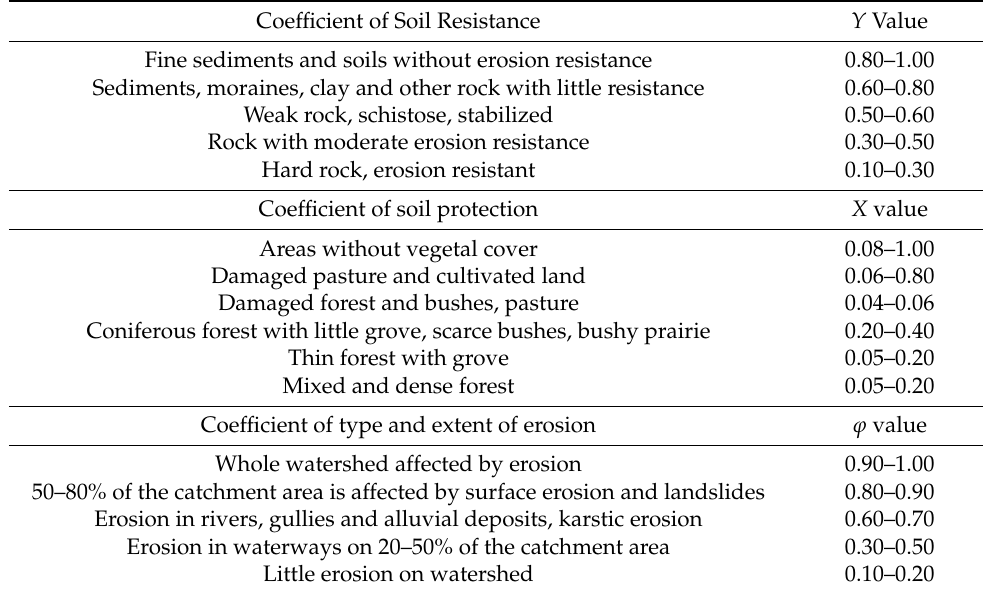
Table 1. Values of the descriptive variables ( Y , X and ϕ ) used in calculating the erosion coefficient ( Z ).